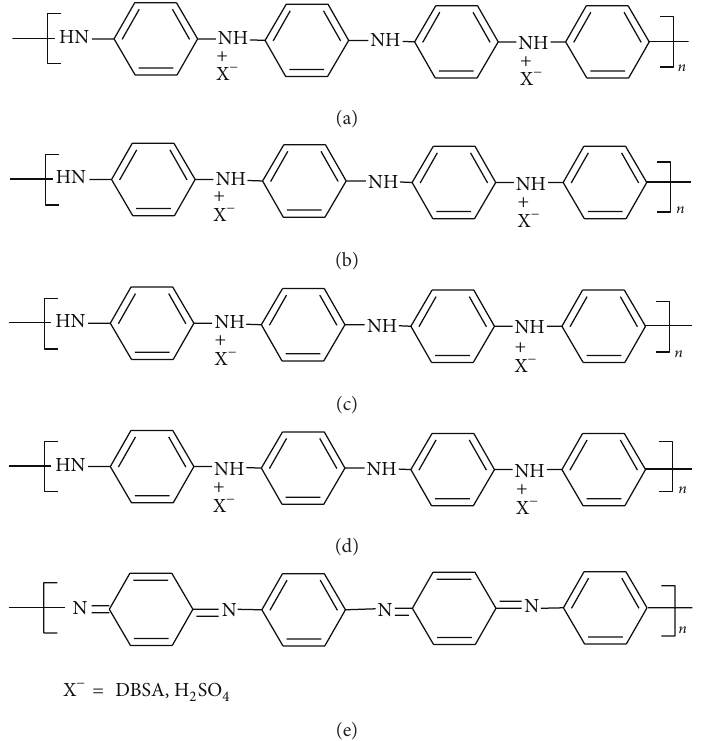
Figure 4: Proposed structures of (a) as-synthesized emeraldine salt and heat treated samples of emeraldine salt up to (b) 250 ∘ C, (c) 490 ∘ C, (d) 500 ∘ C, and (e) 1000 ∘